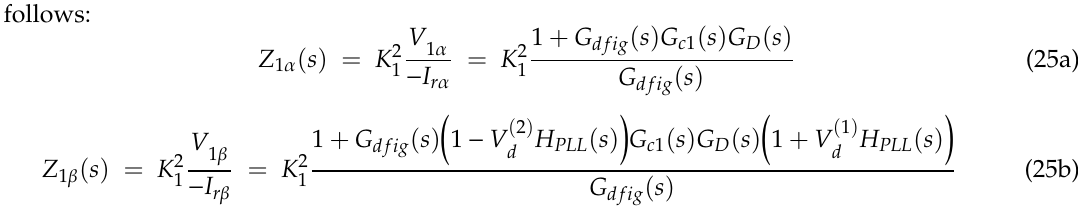
Figure 6. DFIG machine equivalent circuit (a) Overall; (b) simplified.